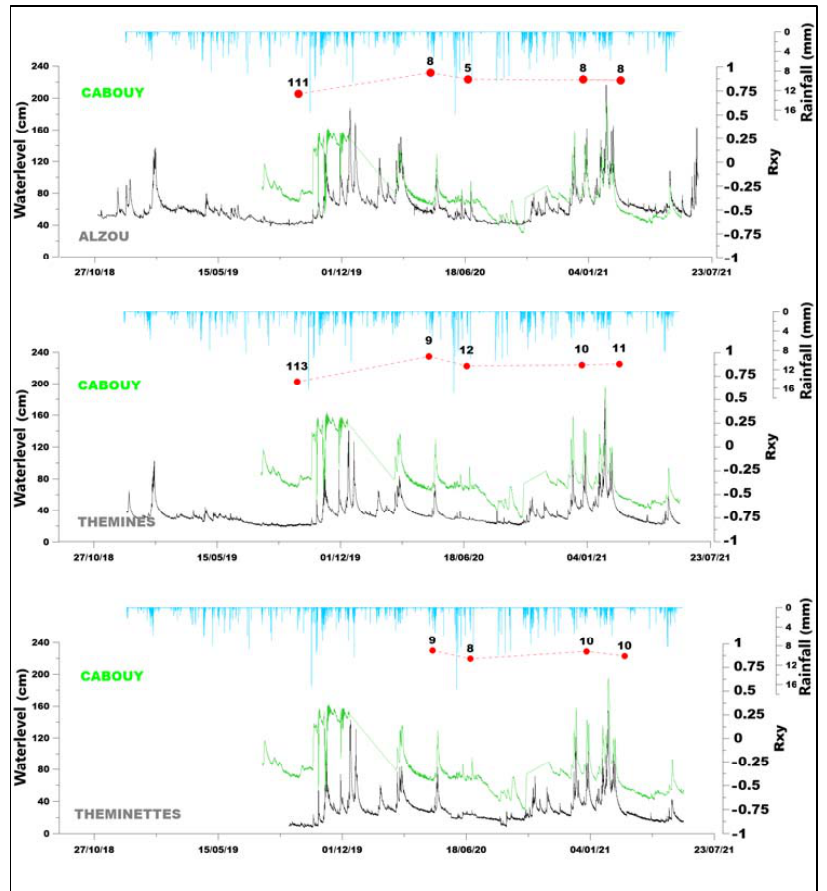
Figure A1. Sliding correlation analyses between the water level for the Cabouy station and the different stations at the sinks; the results of the sliding cross-correlation analyses are displayed in red dots (vertical axis: correlation, label: time lag between the two sites in hours).